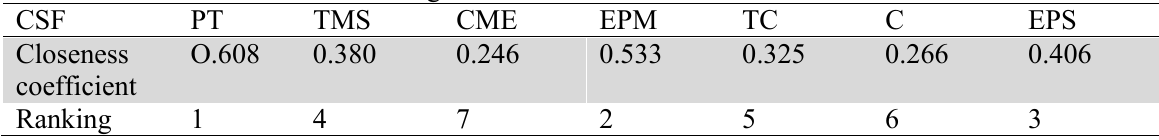
The closeness coefficients and